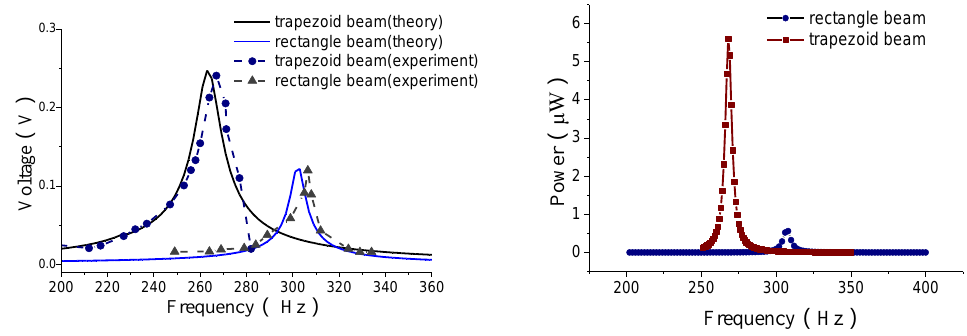
Figure 10. Open voltage and power outputs.